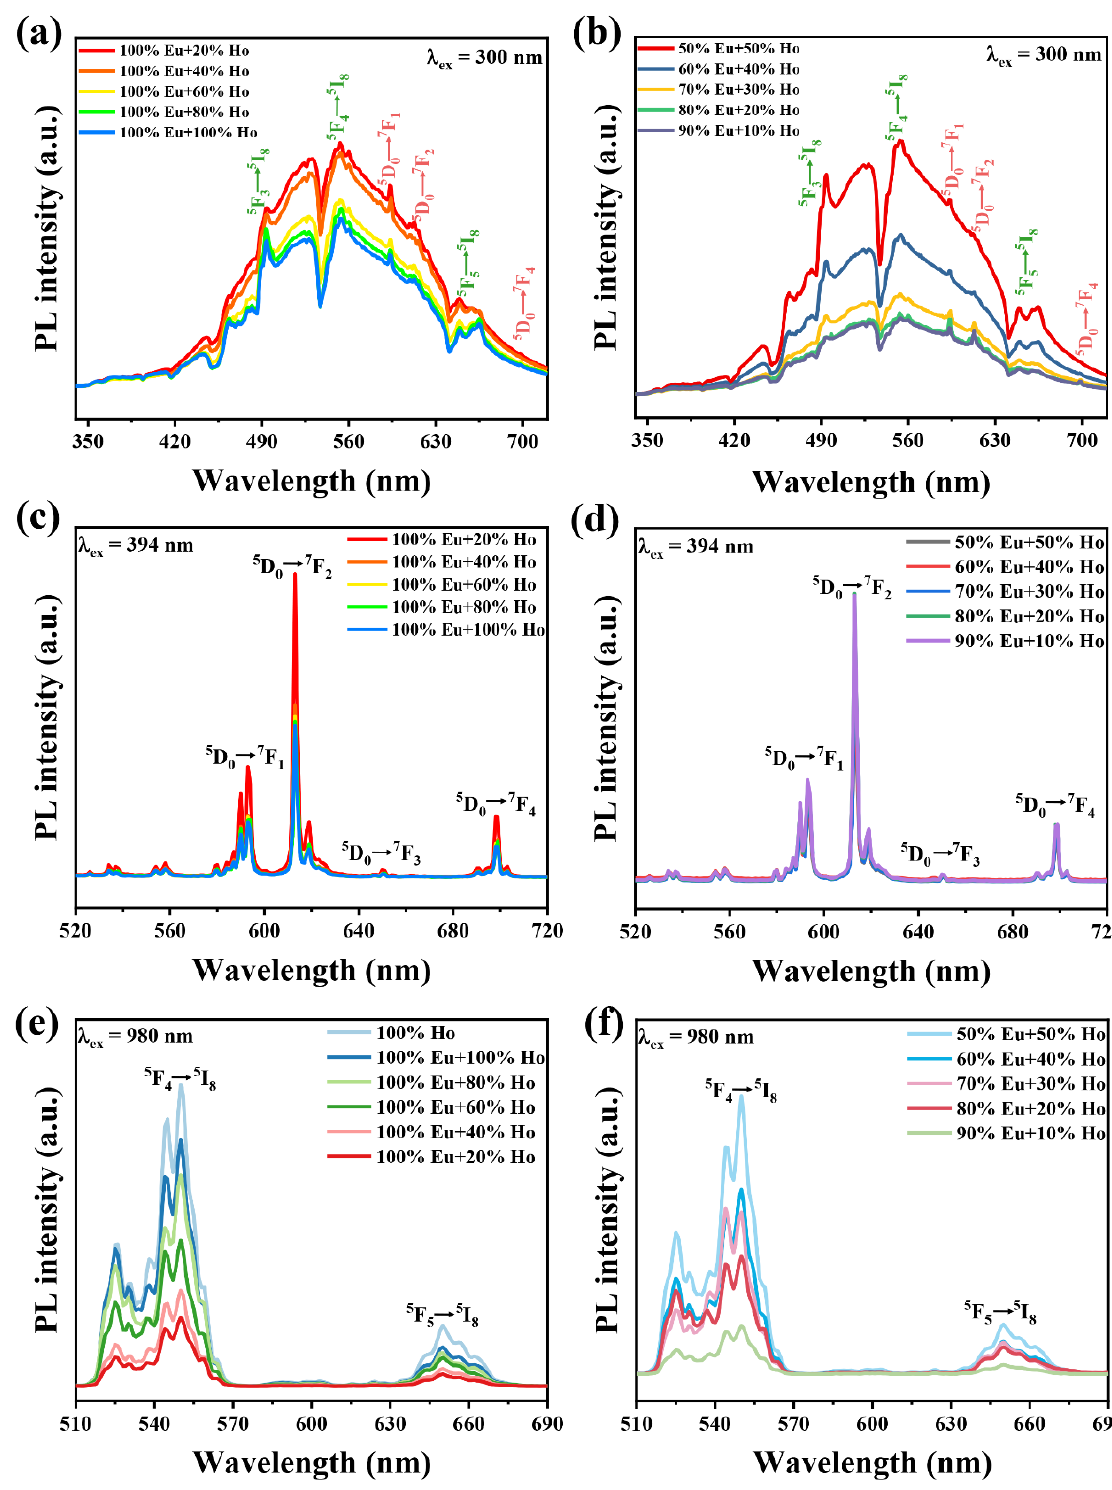
Figure 4. PL spectra of Cs 2 Ag 0.3 Na 0.7 InCl 6 : Yb 3+ /Eu 3+ /Ho 3+ under ultraviolet light excitation at wavelengths of 300 ( a , b ), 394 nm ( c , d ) and NIR laser radiation (980 nm) ( e , f ).